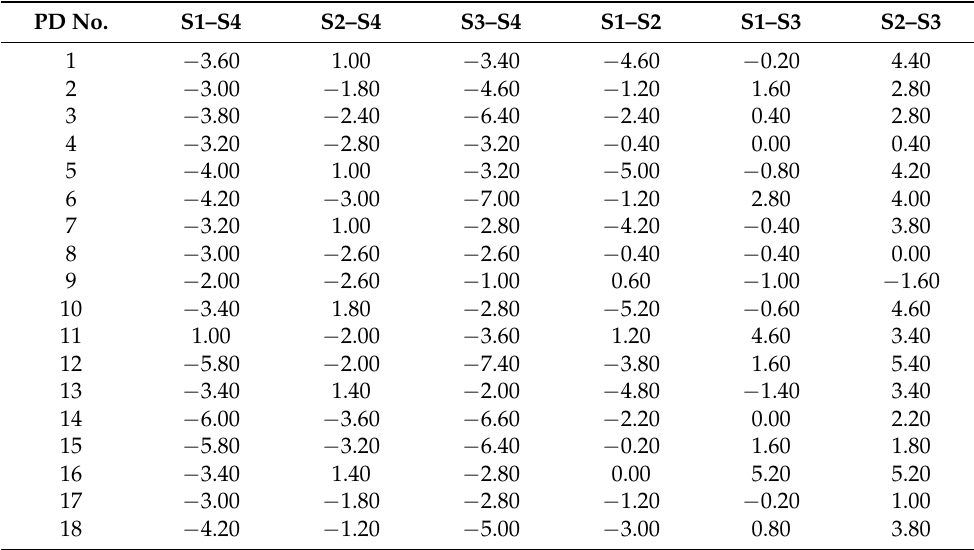
Table 4. Estimated TDOA (ns) by CEM. PD No.